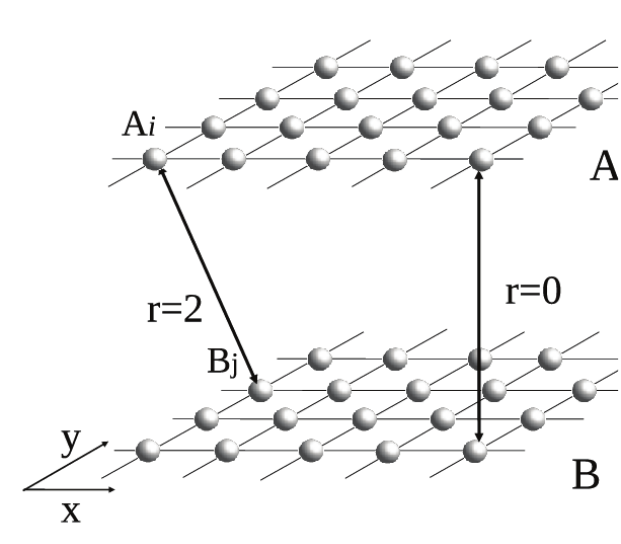
Figure 7. Illustration of interdependent spatial networks. Two square lattices A and B are networks where every node has two types of links: connectivity links and dependency